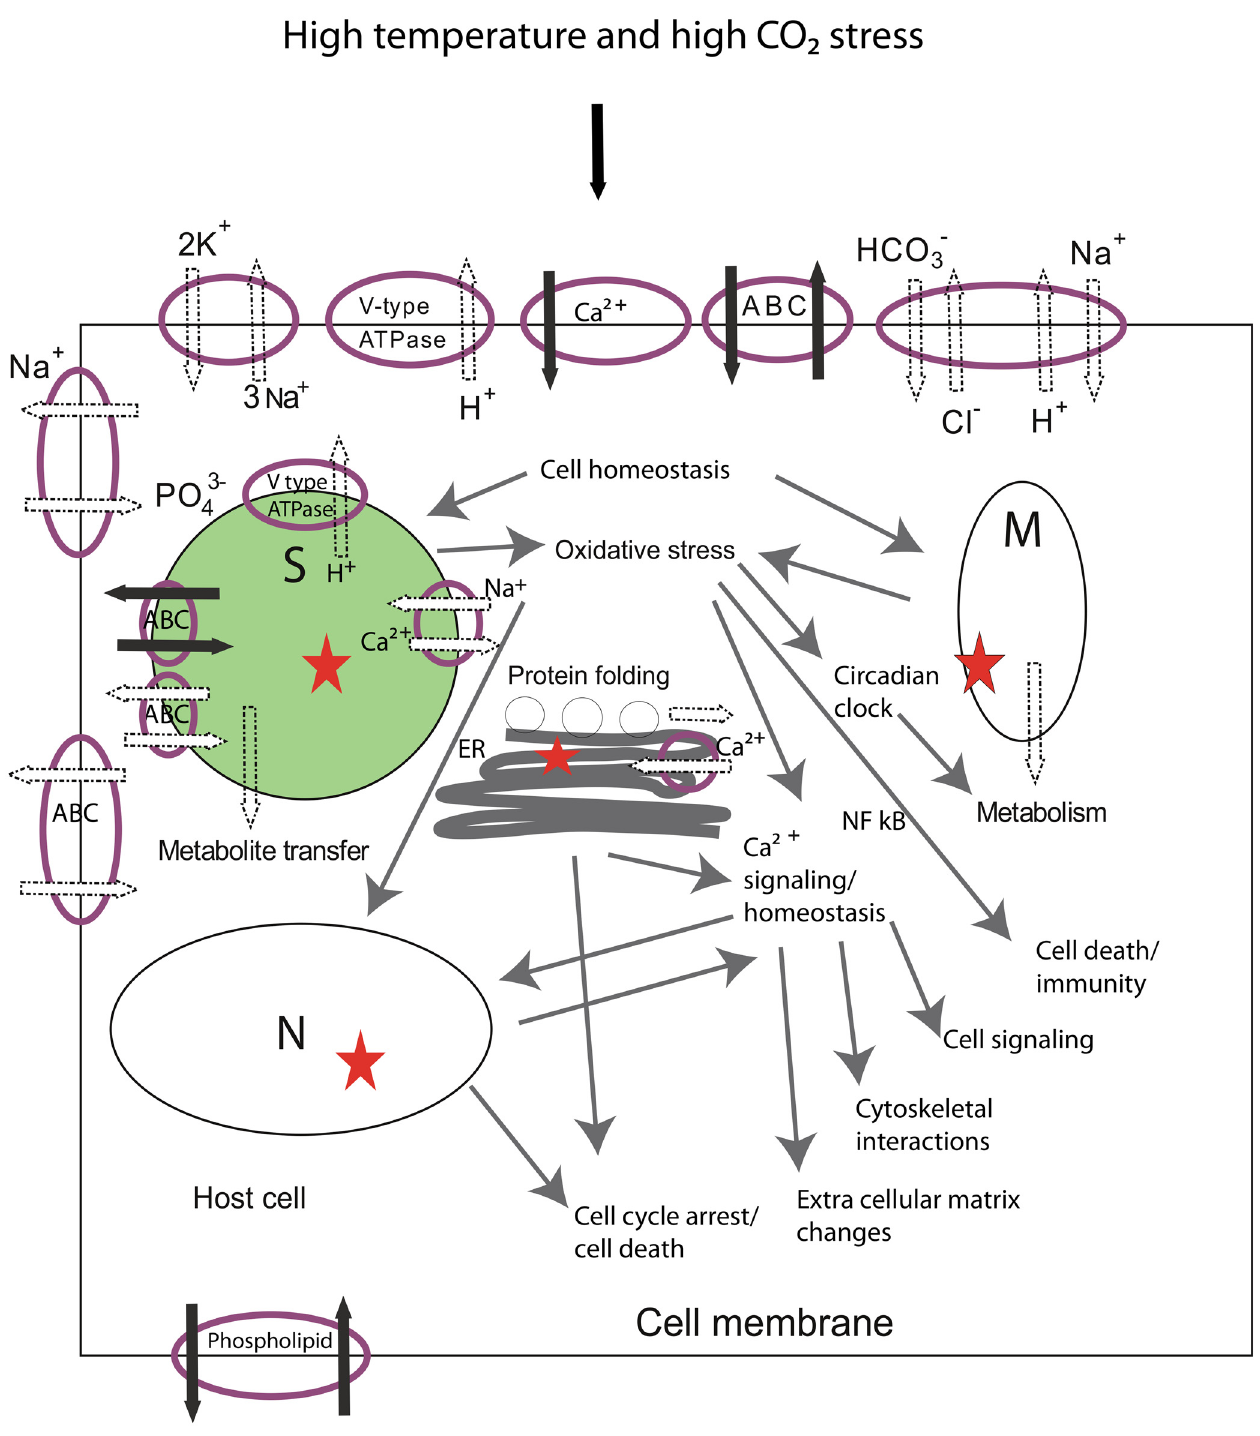
Fig 5. A proposed model of cellular events occurring in response to future Representative Concentration Pathway RCP8.5 scenario with increased temperature and high CO 2 conditions (for gene list see S3 Table). These changes lead to compromised health in Acropora millepora (reduction in symbiont cells, decreased photosynthesis and respiration and reduced calcification). The schematic depicts an endodermal cell which contains the Symbiodinium cell. Cellular events depicted here, especially acid base regulation at the cell membrane are also likely to occur in other cell types which do not contain symbiont cells. Exposure to increased temperature and seawater carbonate chemistry leads to changes in acid base regulation and ion transport at the cell membrane both in coral host and in the symbiont cell. Despite regulatory changes at the cell membrane cellular homeostasis may not be